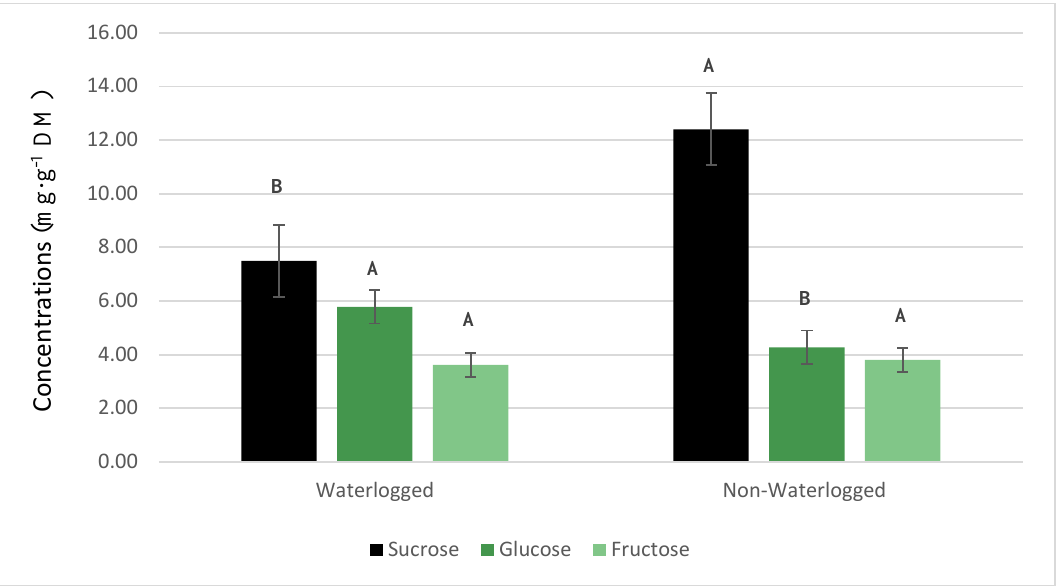
Figure 5. Soluble sugar concentrations in cucumber leaf samples taken from plants that were waterlogged or not waterlogged for 10 days. Plants were harvested and analyzed for soluble sugars at the end of 10 days.